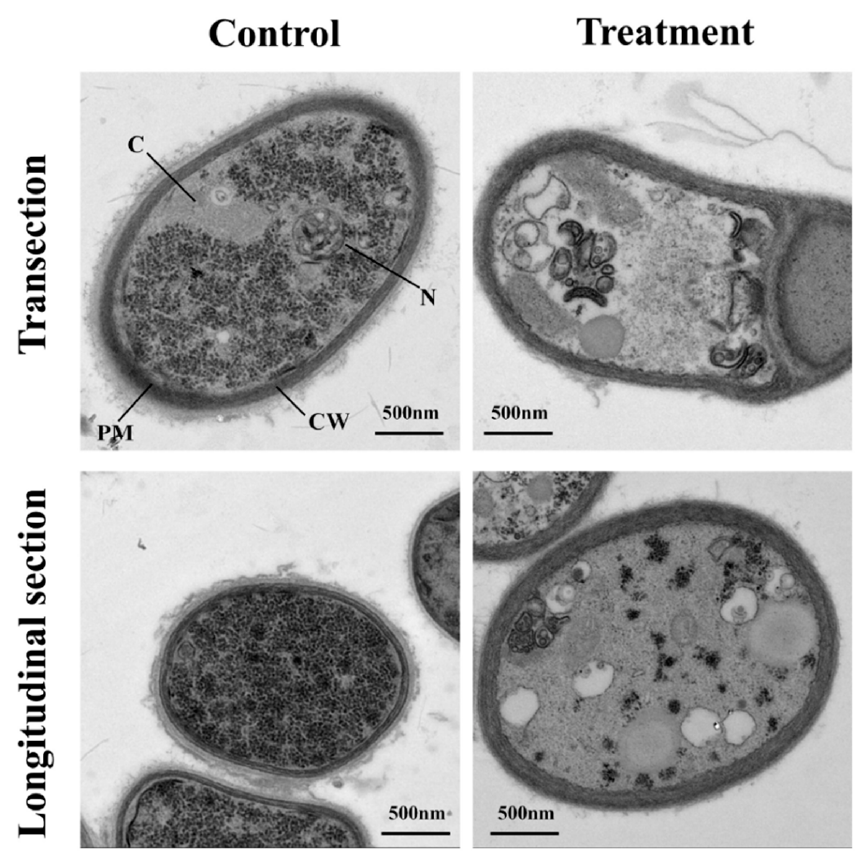
Figure 2. Effects of sterile filtrates on cell ultrastructure of R. cerealis viewed with a transmission electron microscope. The group without sterile filtrates was set as the control. Scale bars represent 500 nm. CW, cell wall; PM, plasma membrane; N, nucleus; C, cytosol.